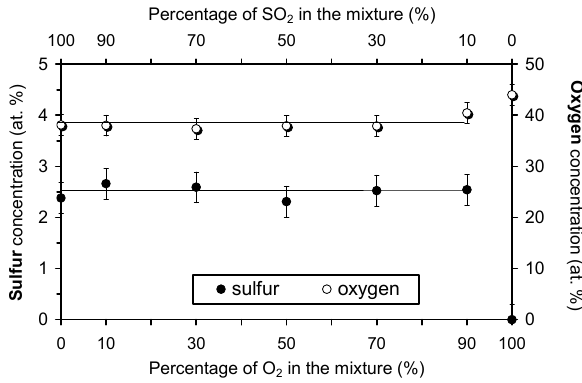
Figure 4. Concentration of sulfur and oxygen on the PET polymer treated in various SO 2 + O 2 mixtures. Zero percent of O 2 in the mixture refers to pure SO 2 plasma, whereas 100% of O 2 refers to pure oxygen plasma.